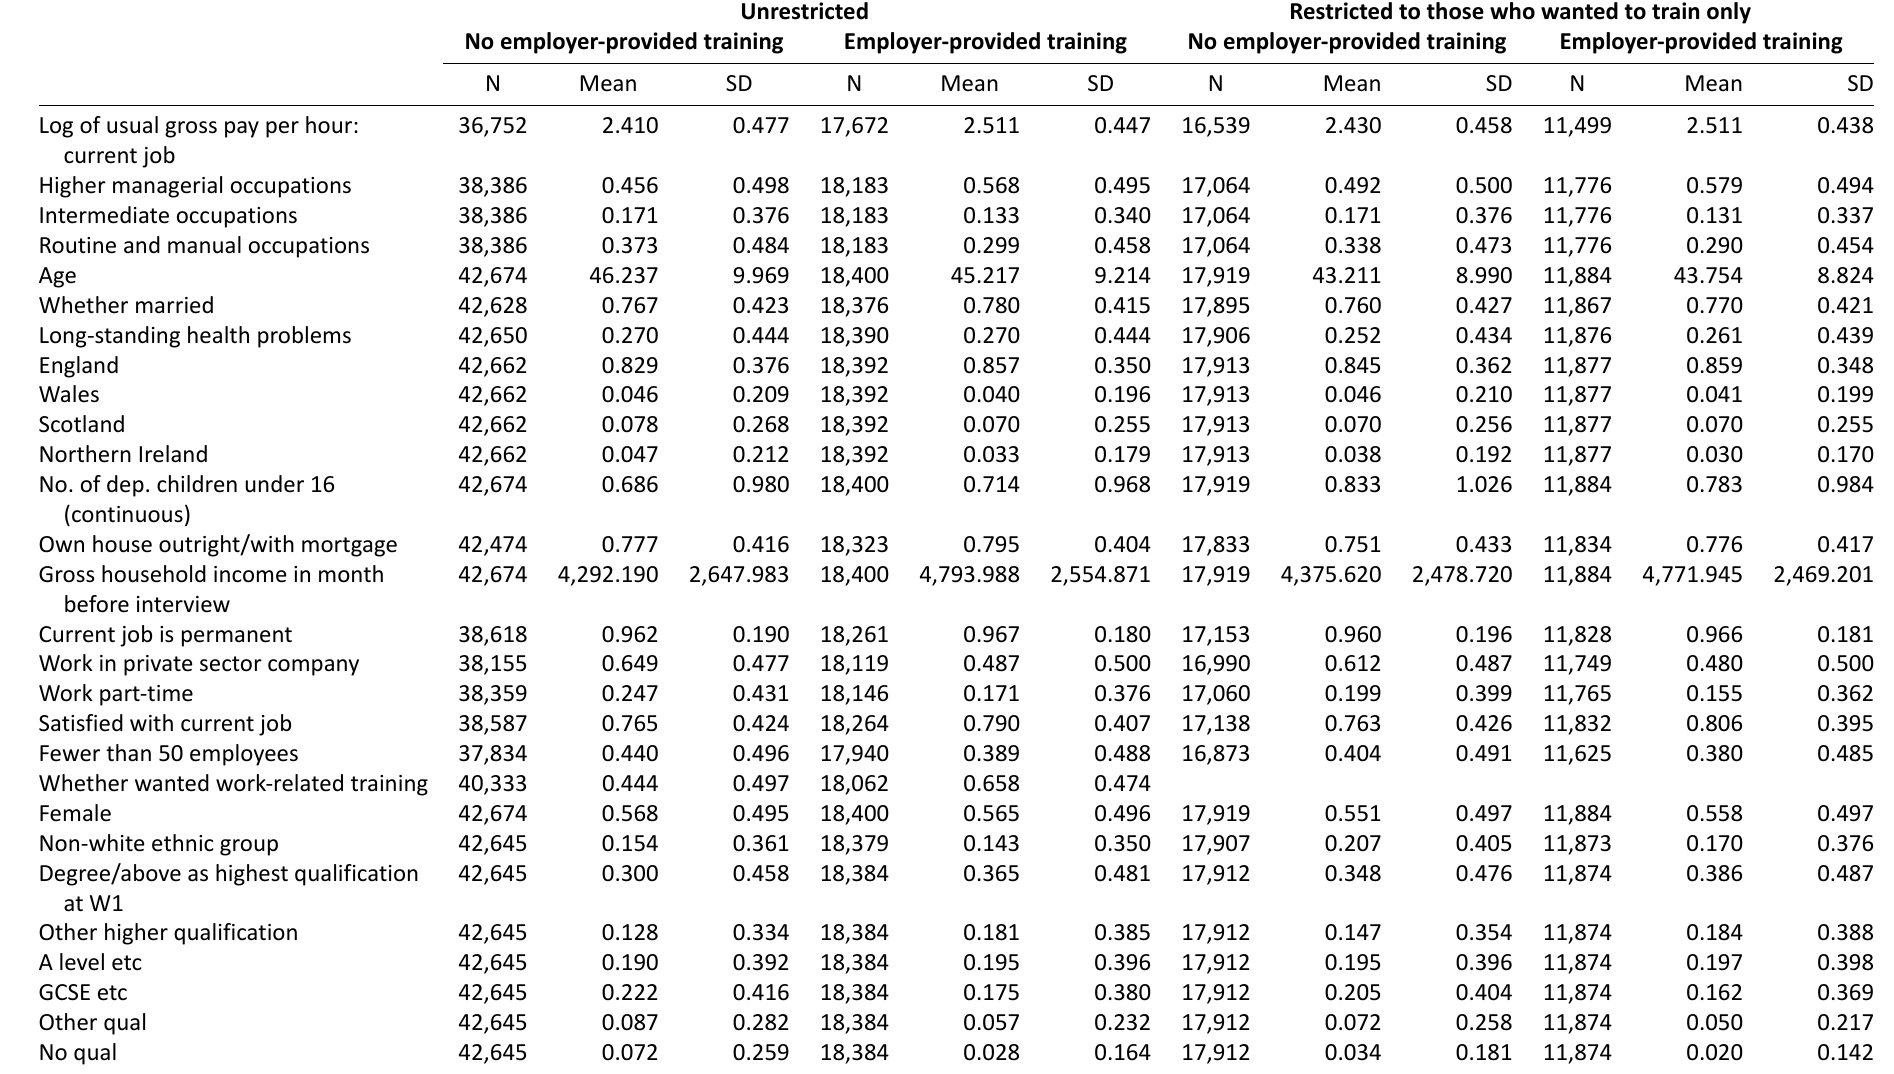
Table A3. Individual characteristics by participation in employer-provided training, unrestricted and restricted samples. Unrestricted Restricted to those who wanted to train